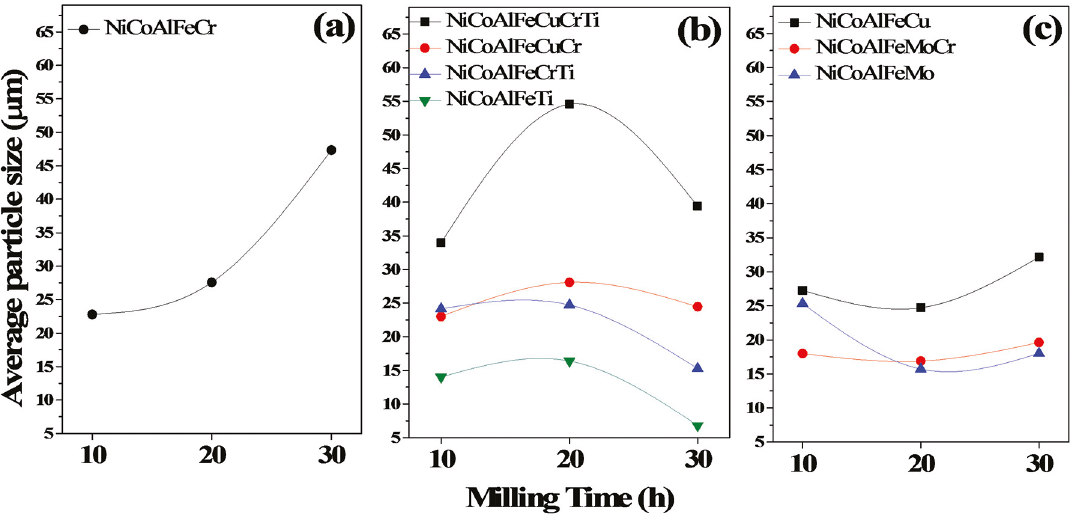
Figure 2: NiCoAlFeCuCrTi powders after 10, 20 and 30 h of milling respectively, showing their morphology in SEM micrographs (a, b and c), and lamellar microstructure in FE-SEM micrographs (d, e and f).